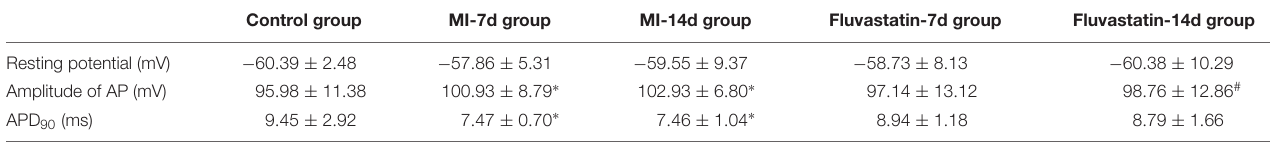
TABLE 2 | The parameters of AP in five